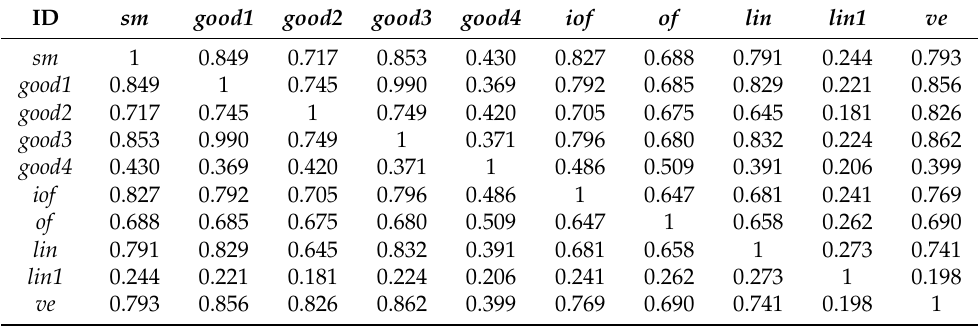
Table 6. Adjusted Rand index values—the consistency of classifications obtained for 10 different distance measures.